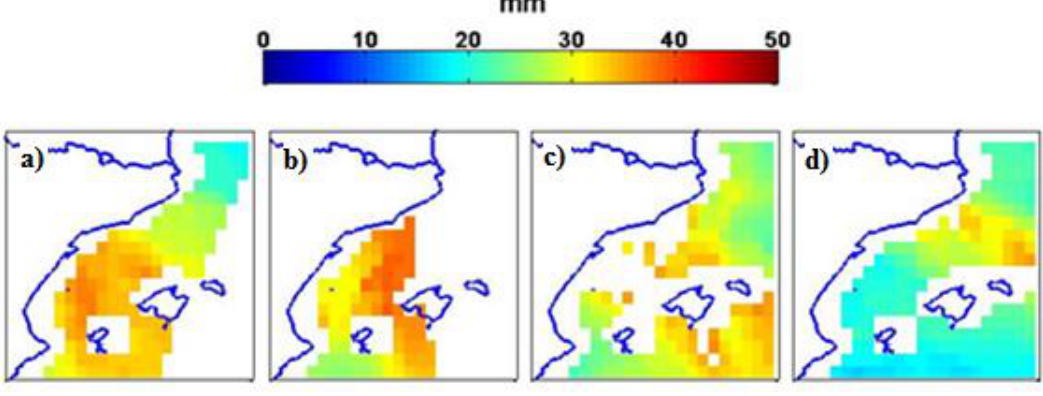
Fig. 9. Columnar water vapor measured by AMSR-E during the episode, each image corresponding to passes at: (a) 02:24 UTC 9 May, (b) 13:36 UTC 9 May, (c) 01:30 UTC 10 May, and (d) 12:42UTC 10 May (source: Figure 9. Columnar water vapor measured by AMSR-E during the episode, each image 3 corresponding to passes at: a) 02:24UTC 9 May, b) 13:36UTC 9 May, c) 01:30UTC 10 4 May, and d) 12:42UTC 10 May (source: http://www.remss.com/). 5